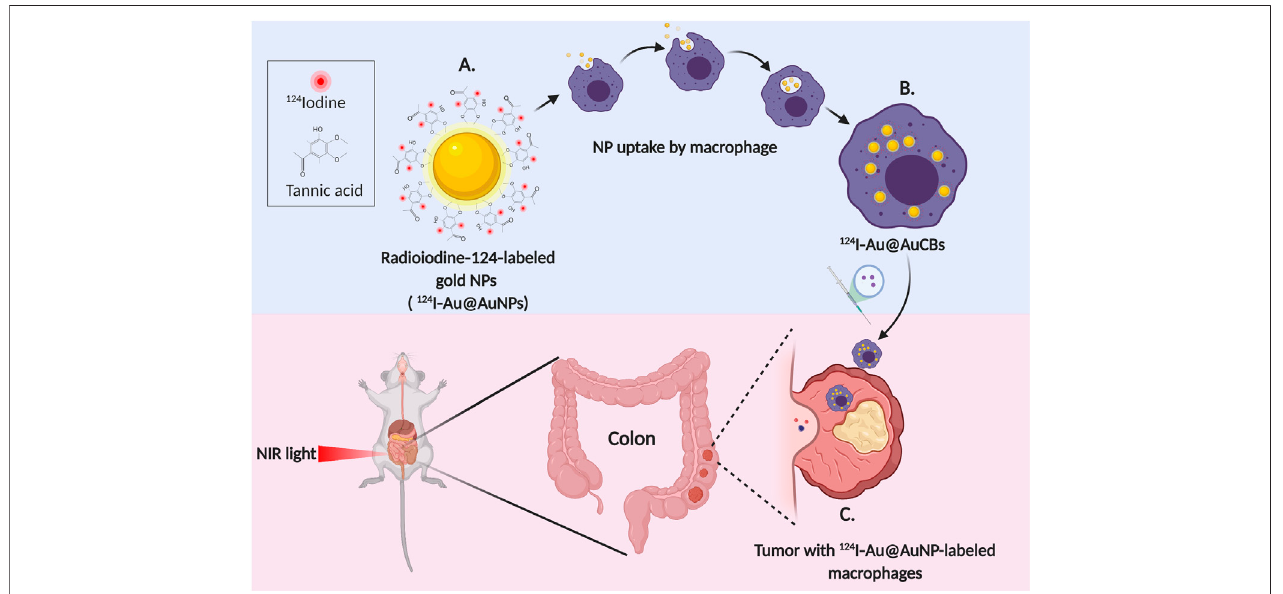
FIGURE 3 | Macrophage mediated photothermal therapy and imaging of colon cancer (A) Radioiodine-124-labeled gold nanoparticles with crushed gold shells (124I-Au@AuNPs) (B) Uptake of 124I-Au@AuCBs by macrophage (C) Ablation and imaging of the tumor (Created with BioRender.com).